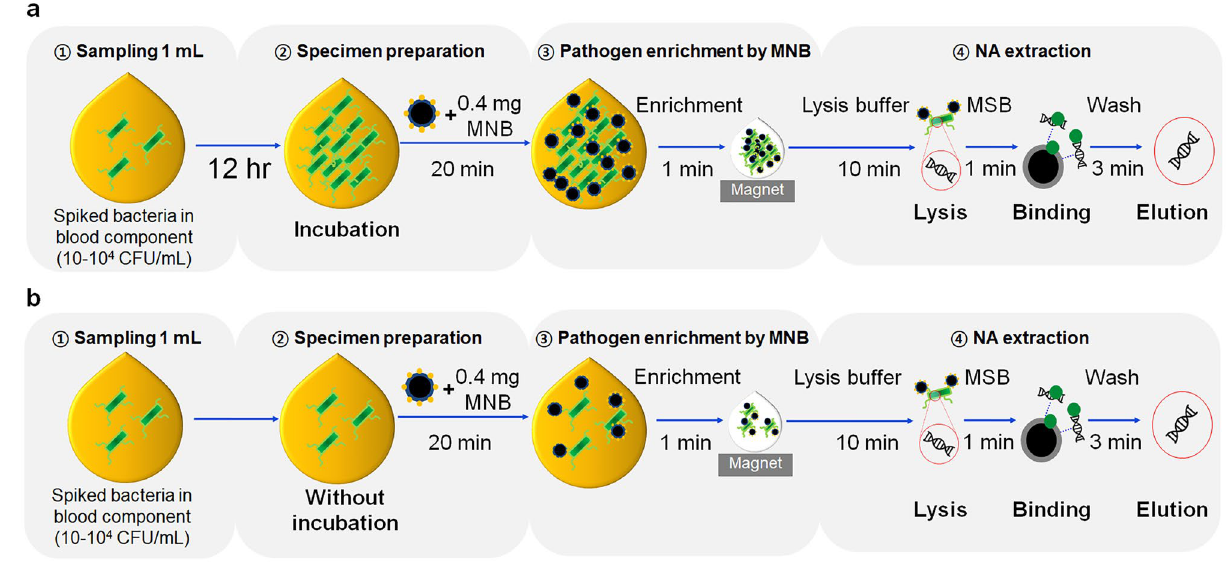
Figure 1. Schematic illustration of pathogen enrichment by MNBs (magnetic nanobeads) and NA (nucleic acid) extraction from 1-mL samples of blood components spiked with bacteria ( a ) after 12 h of specimen incubation at RT (room temperature), and ( b ) without prior specimen incubation. The procedural steps were as follows: sampling, specimen preparation, pathogen enrichment by MNBs, and NA